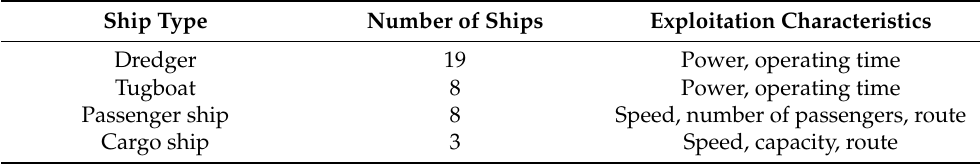
Table 1. The Croatian inland waterway fleet by ship type and their exploitation